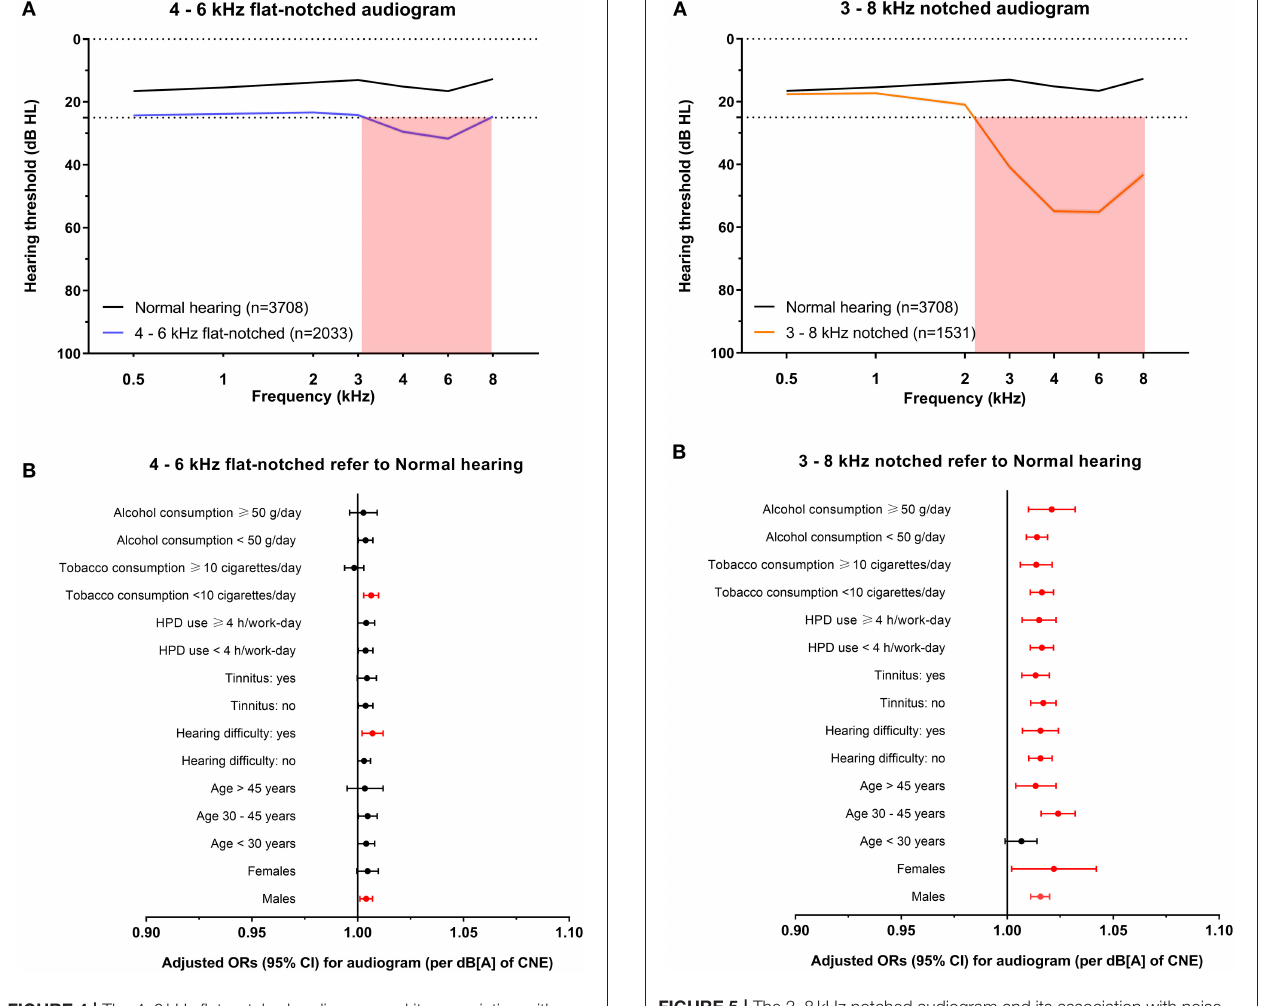
FIGURE 4 | The 4–6kHz flat-notched audiogram and its association with noise exposure. (A) The average hearing thresholds over 0.5–8kHz frequencies of subjects with normal hearing and the cluster of 4–6kHz flat-notched audiogram. The pink shade includes the range of notched frequencies. (B) Adjusted ORs with 95% CI of CNE increment (per dB[A]) for the 4–6kHz flat-notched audiogram refer to normal hearing audiogram after